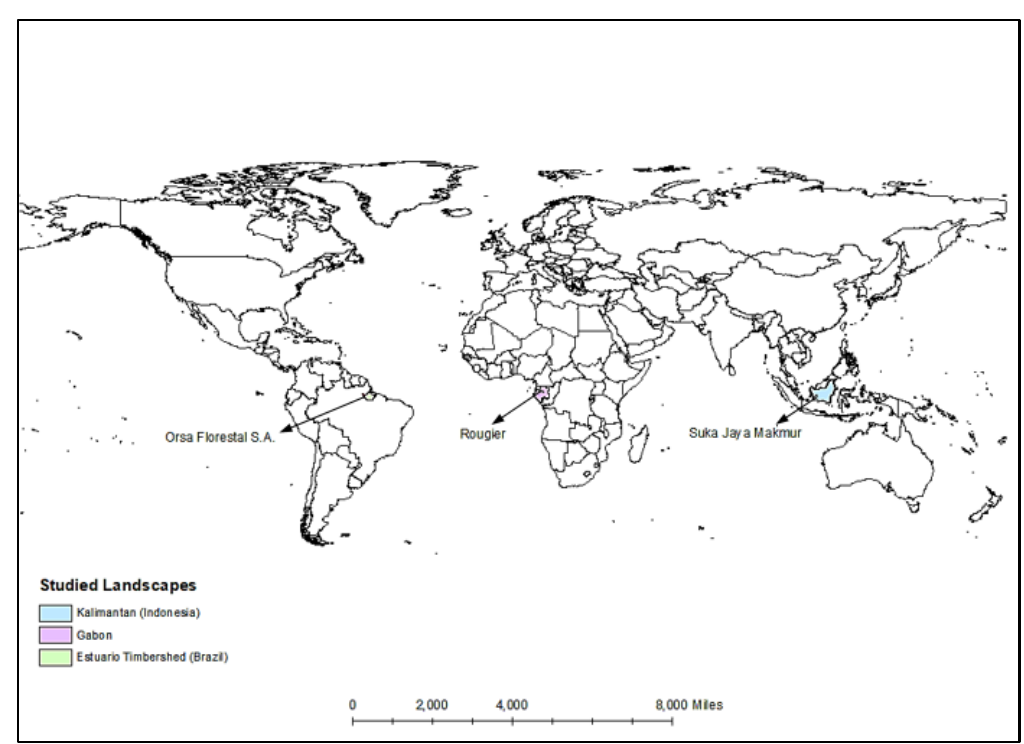
Figure 1. Locations of Orsa Florestal S.A., Rougier, and Suka Jaya Makmur in studied landscapes.